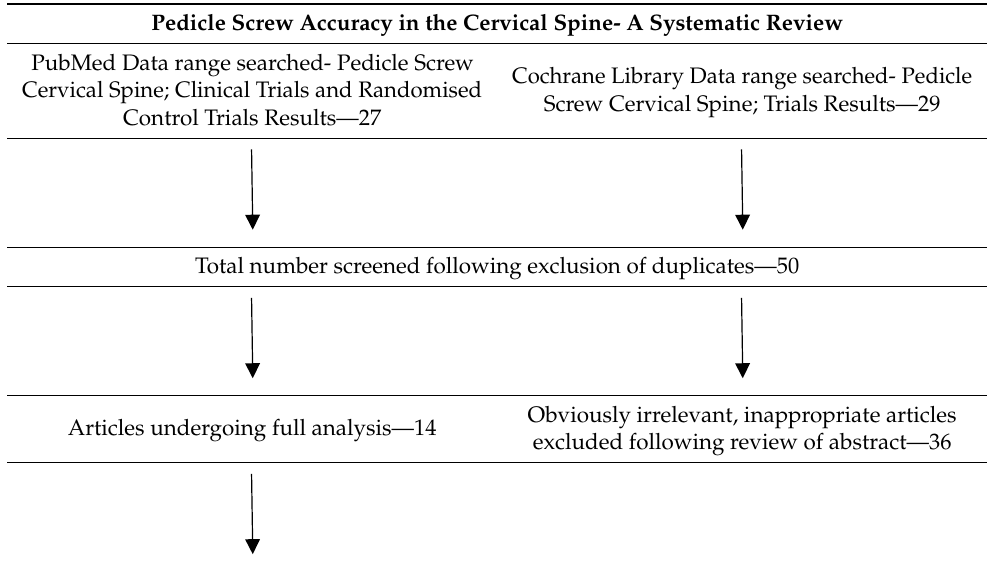
Table 1. PRISMA diagram outlining how the systematic review was conducted.